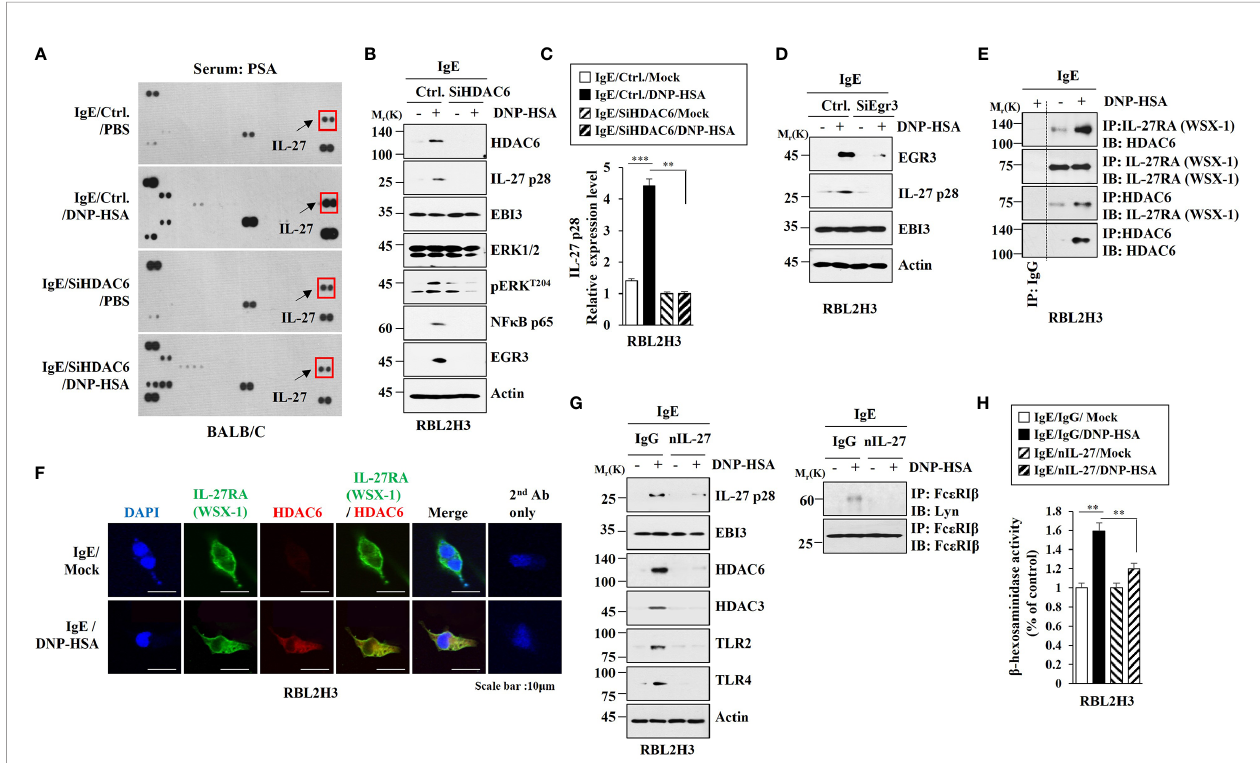
( Figure S4B ) but increased Egr3 expression at the transcriptional level in BALB/C mice ( Figure S4B ). MiR-182-5p mimic inhibited increases of EGR3, HDAC6, TLR2, TLR4, and COX2 expression levels ( Figure S4C ) and interactions of Fc ϵ RI with HDAC3 and Lyn in BALB/C mice induced by PCA ( Figure S4C ). MiR-182-5p mimic inhibited decrease of rectal temperature ( Figure S5A ) and increase of b -hexosaminidase activity in BALB/C mice induced by PSA ( Figure S3B ). PSA decreased the expression of miR-182-5p in BALB/C mice ( Figure S5B ). MiR-182-5p mimic inhibited increases of EGR3, HDAC6, and HDAC3 expression levels in BALB/C mice induced by PSA ( Figure S5C ). Immunohistochemical staining employing lung tissues showed that miR-182-5p mimic inhibited increase of EGR3 expression in BALB/C mice induced by PSA ( Figure S5D ). These results indicate that miR- 182-5p can inhibit anaphylaxis by regulating expression levels of EGR3 and